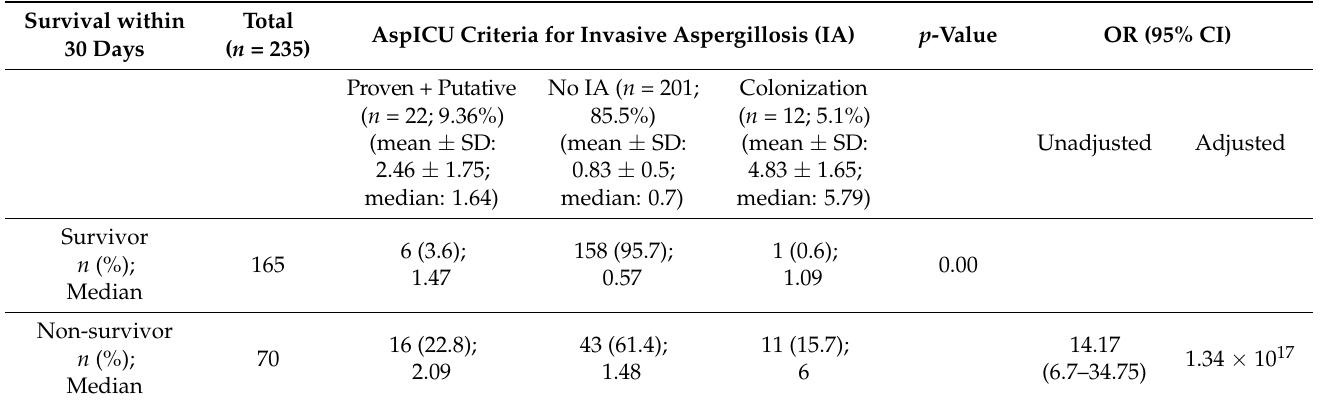
Table 3. Galactomannan values using AspICU diagnostic criteria and the outcomes.